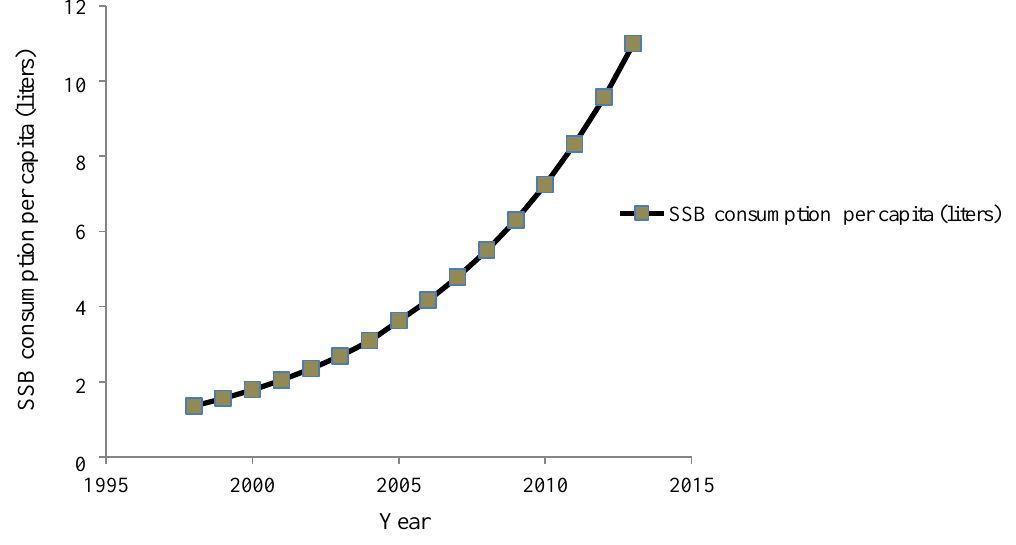
Figure 6. SSB consumption in liters per capita in India, 1998–2013.